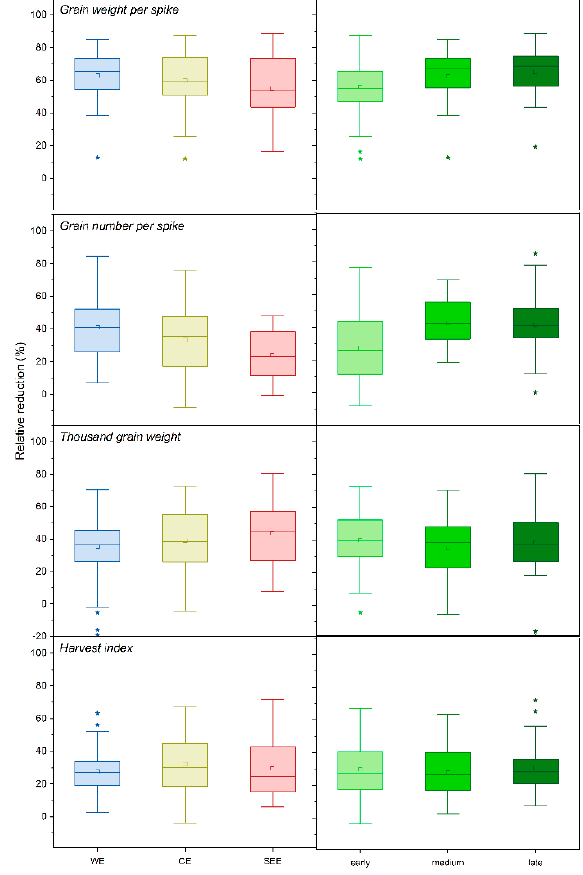
Figure 5. Boxplots showing differences in yield formation parameters between wheat genotypes grouped according to site of origin ( left ) and time to maturity ( right ). The medians (central line), means (squares), 25th and 75th percentiles (boxes), 1.5 interquartile ranges (error bars), and outliers (stars) are presented ( n ≥ 15).